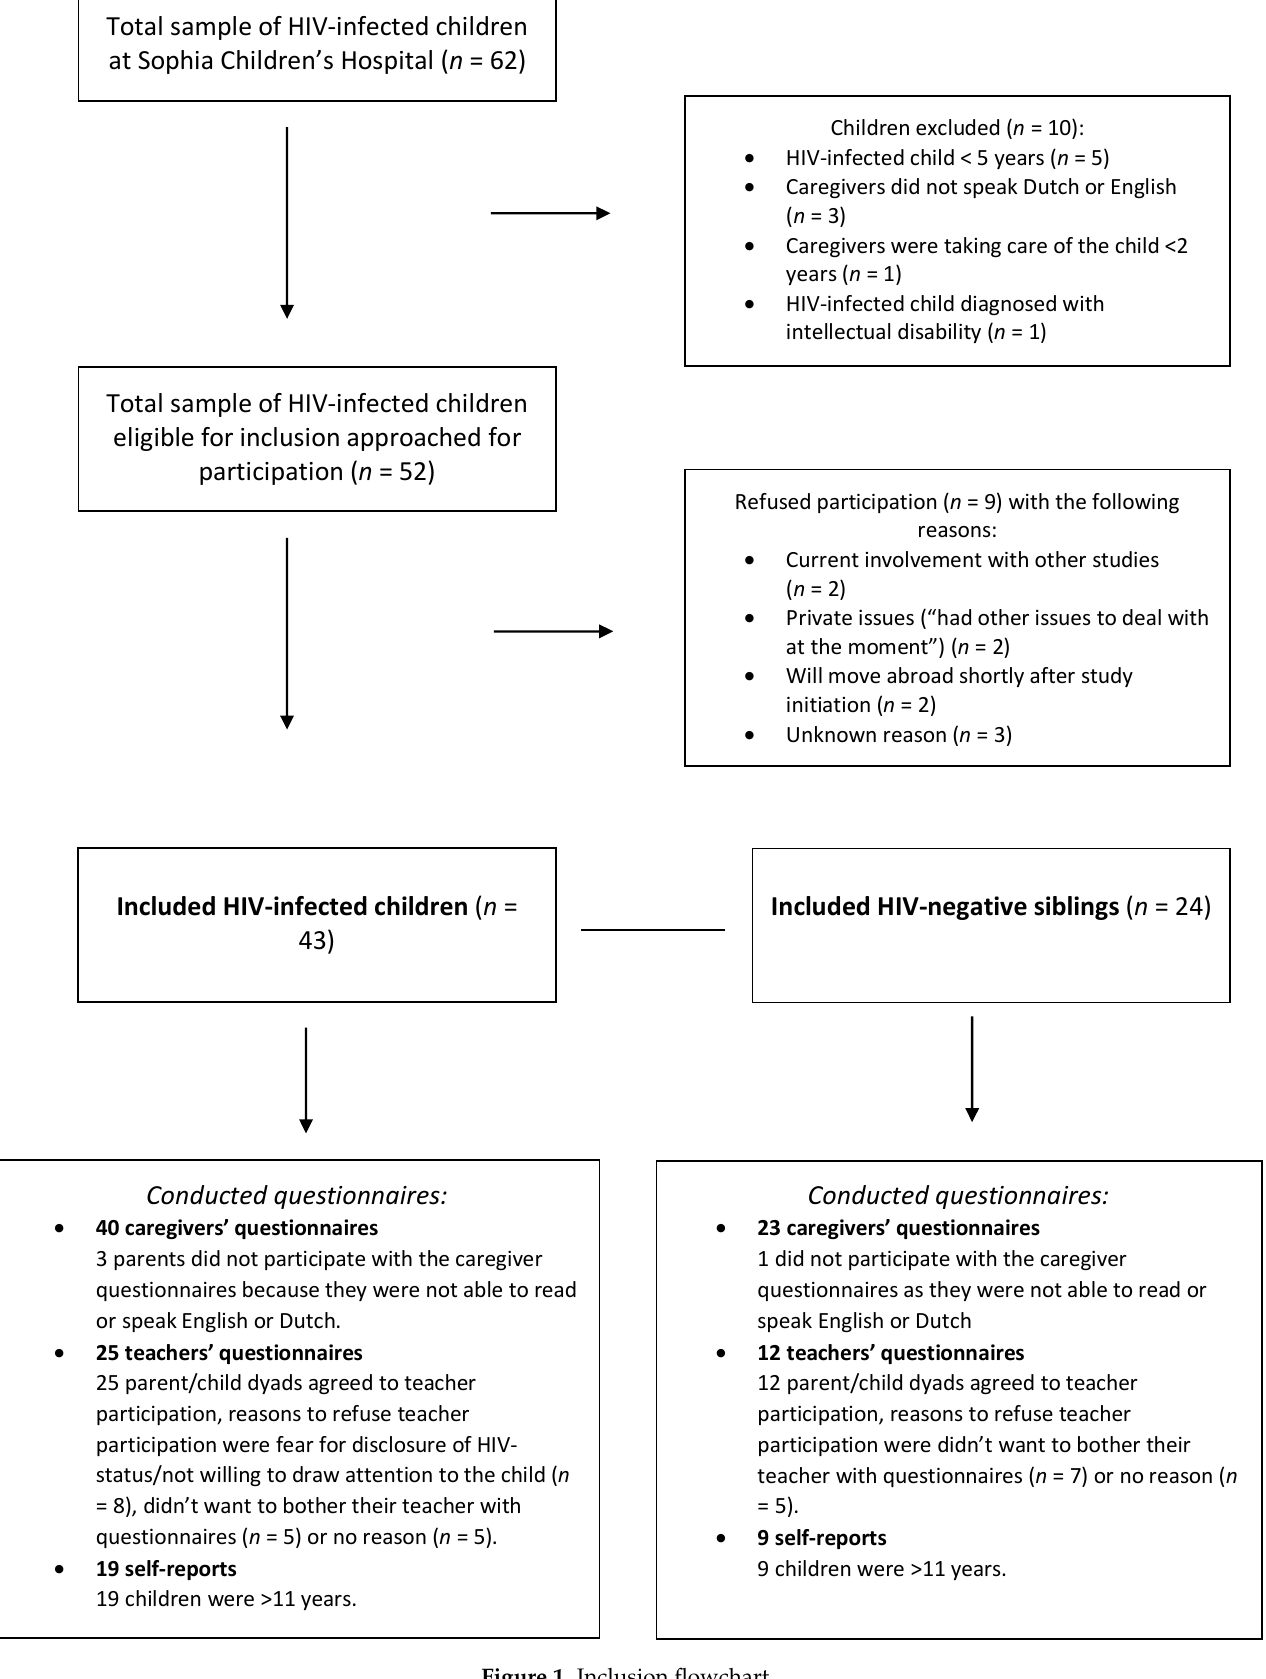
Figure 1. Inclusion flowchart.